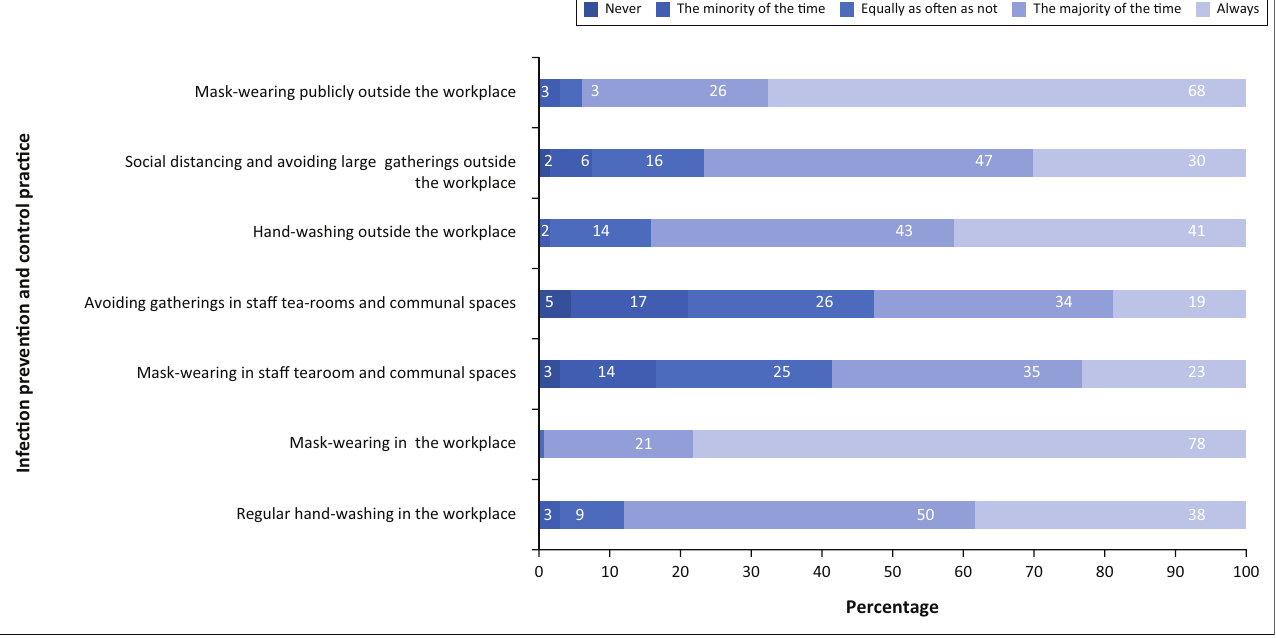
FIGURE 2: Infection prevention and control behaviours of surveyed doctors at Nelson Mandela Bay Public